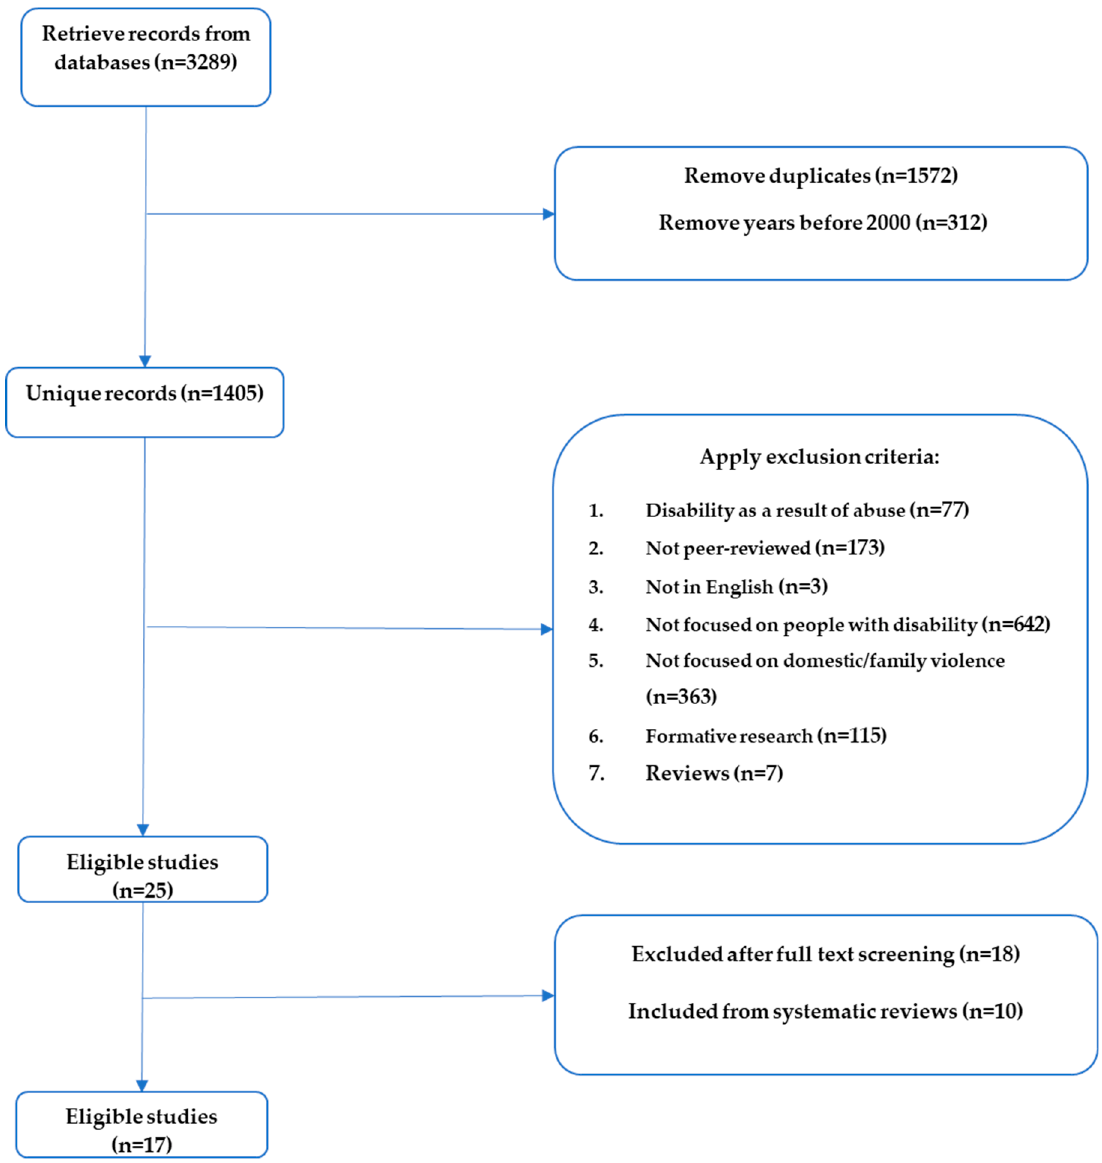
Figure 1. Systematic search